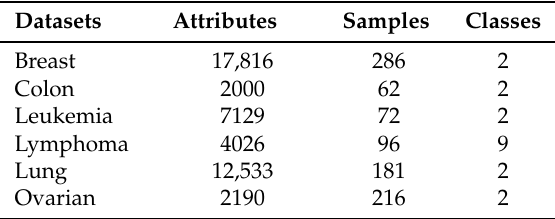
Table 1. The datasets considered for the